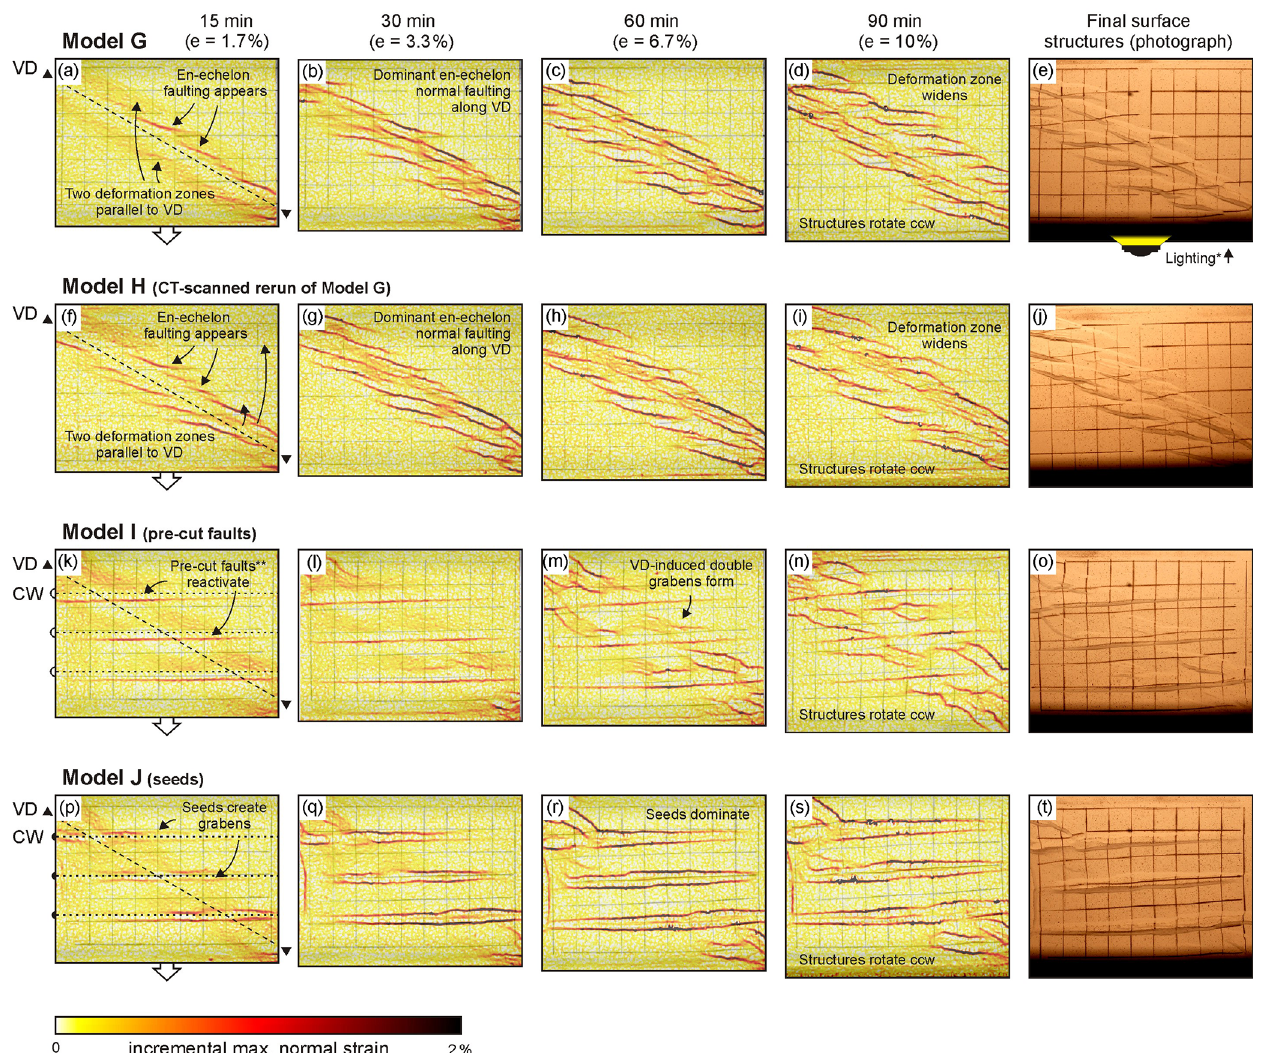
Figure 5. Incremental maximum normal strain maps of models G–J from Sub-series 2.1 (with 30 ◦ oblique VD and model axis-parallel crustal weaknesses in the brittle cover, if applied) obtained through PIV analysis, taken as a proxy of fault activity. The increments for PIV analysis were 1min, i.e. every 0.33mm of extension. The original model map-view pictures are visible in the background. The right-hand column depicts the model surface at the end of each experiment. VD: velocity discontinuity. CW: (simulated) crustal weakness. ccw: counter- clockwise. ∗ Shadows cast by one-sided lighting allowing a better visualization of the final surface structures. ∗∗ The location of the pre-cut faults at the base of the sand layer are indicated, the offset of their surface expression is due to their inclination (Fig.